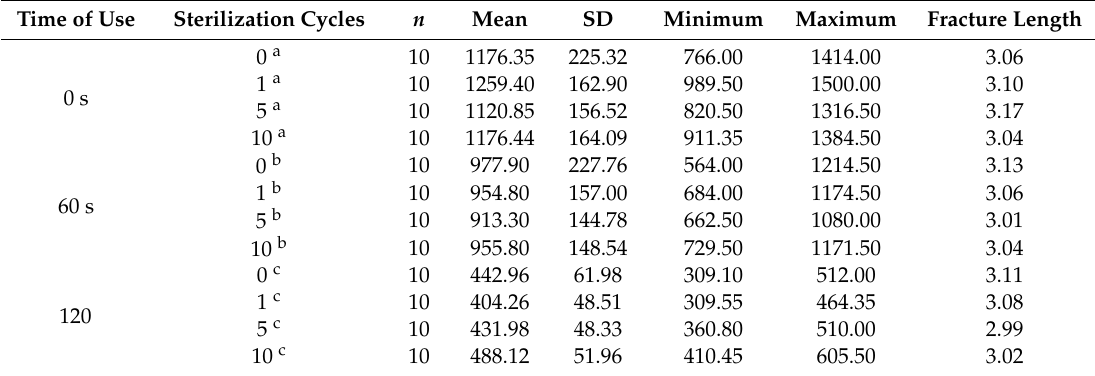
Table 3. Descriptive statistics of the number of cycles to failure of the time of use and the sterilization cycles study groups.